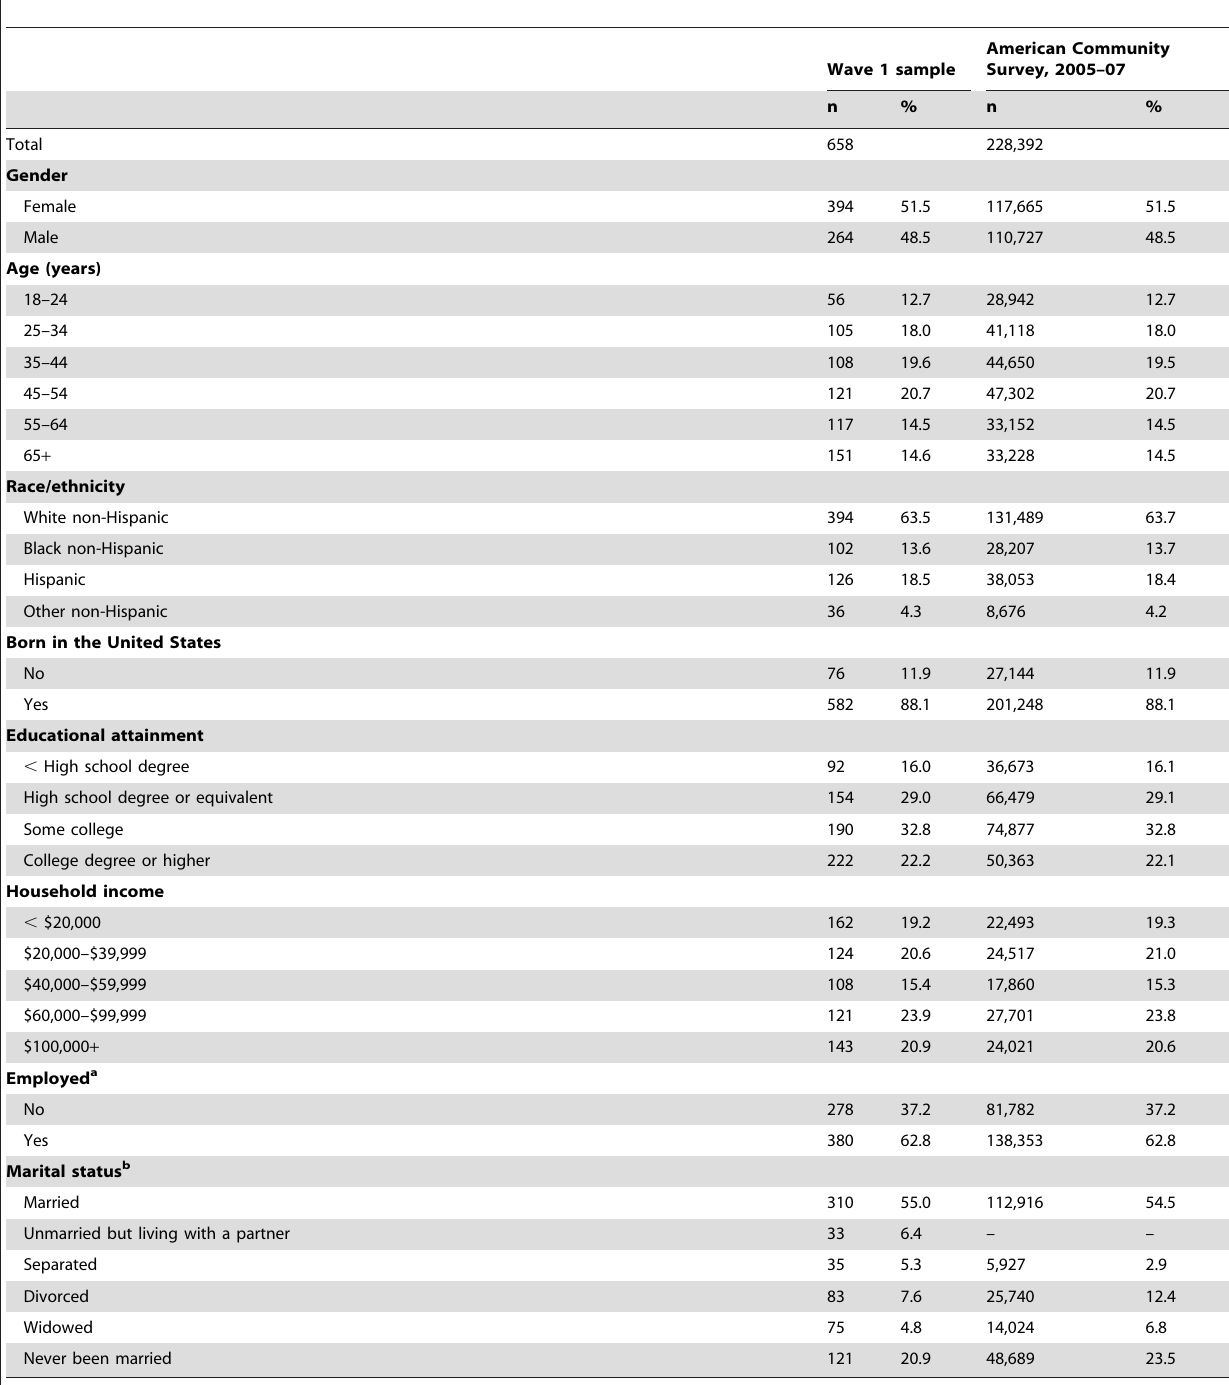
Table 1. Baseline demographic and socioeconomic characteristics of the sample, compared to American Community Survey data for Galveston and Chambers counties,